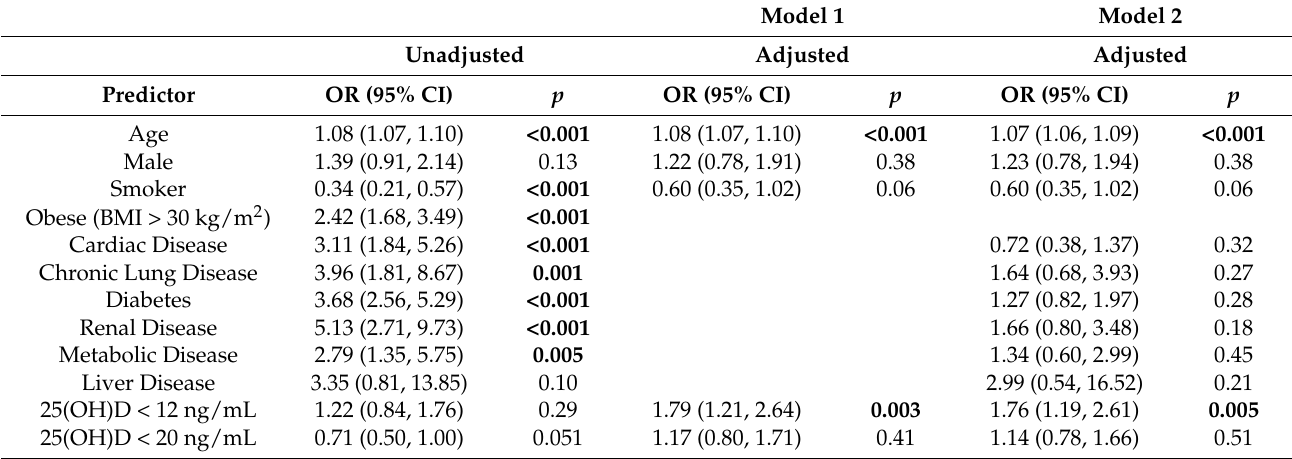
Table 2. Predictors for COVID-19 severity using multivariate ordered logistic regression analysis.